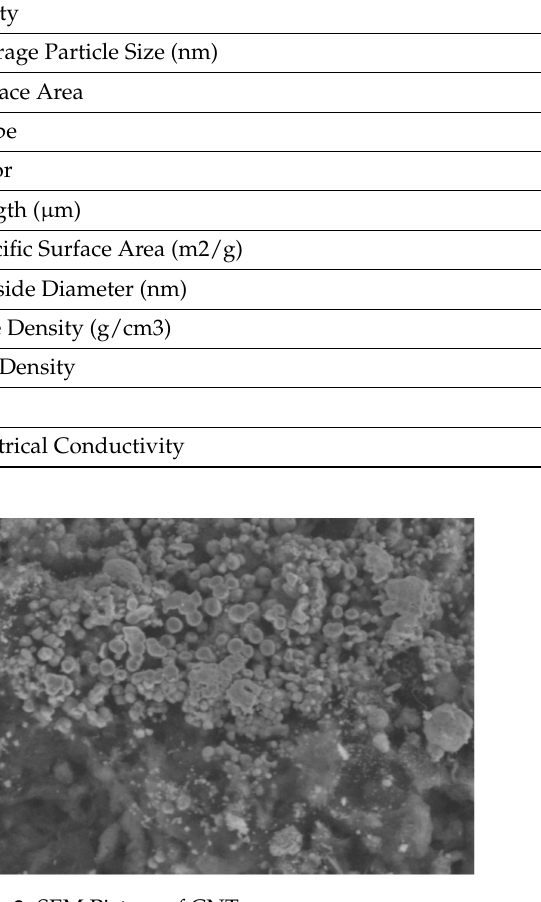
Figure 3. SEM Picture of CNT. The cement was CEM I 42.5 with a density of 3.15 g/cm 3 . The cement’s compositions are given in Table